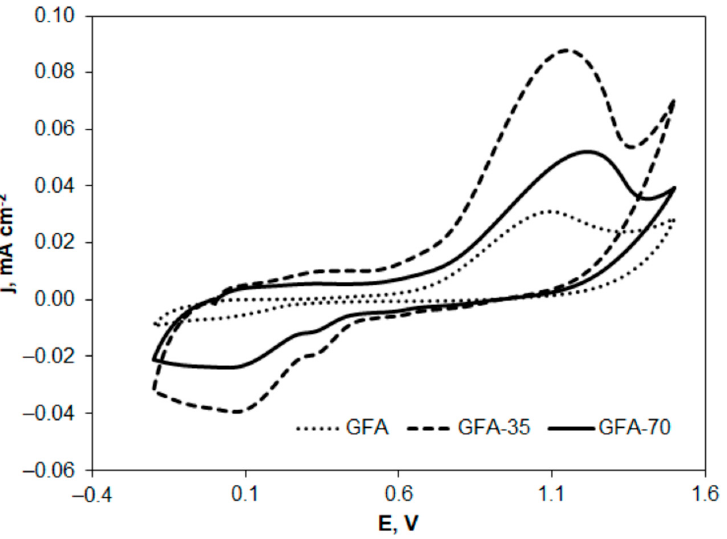
Figure 7. Cyclic voltammograms of 4-chlorophenol solution (1 × 10 − 3 mol L − 1 in 0.05 mol L − 1